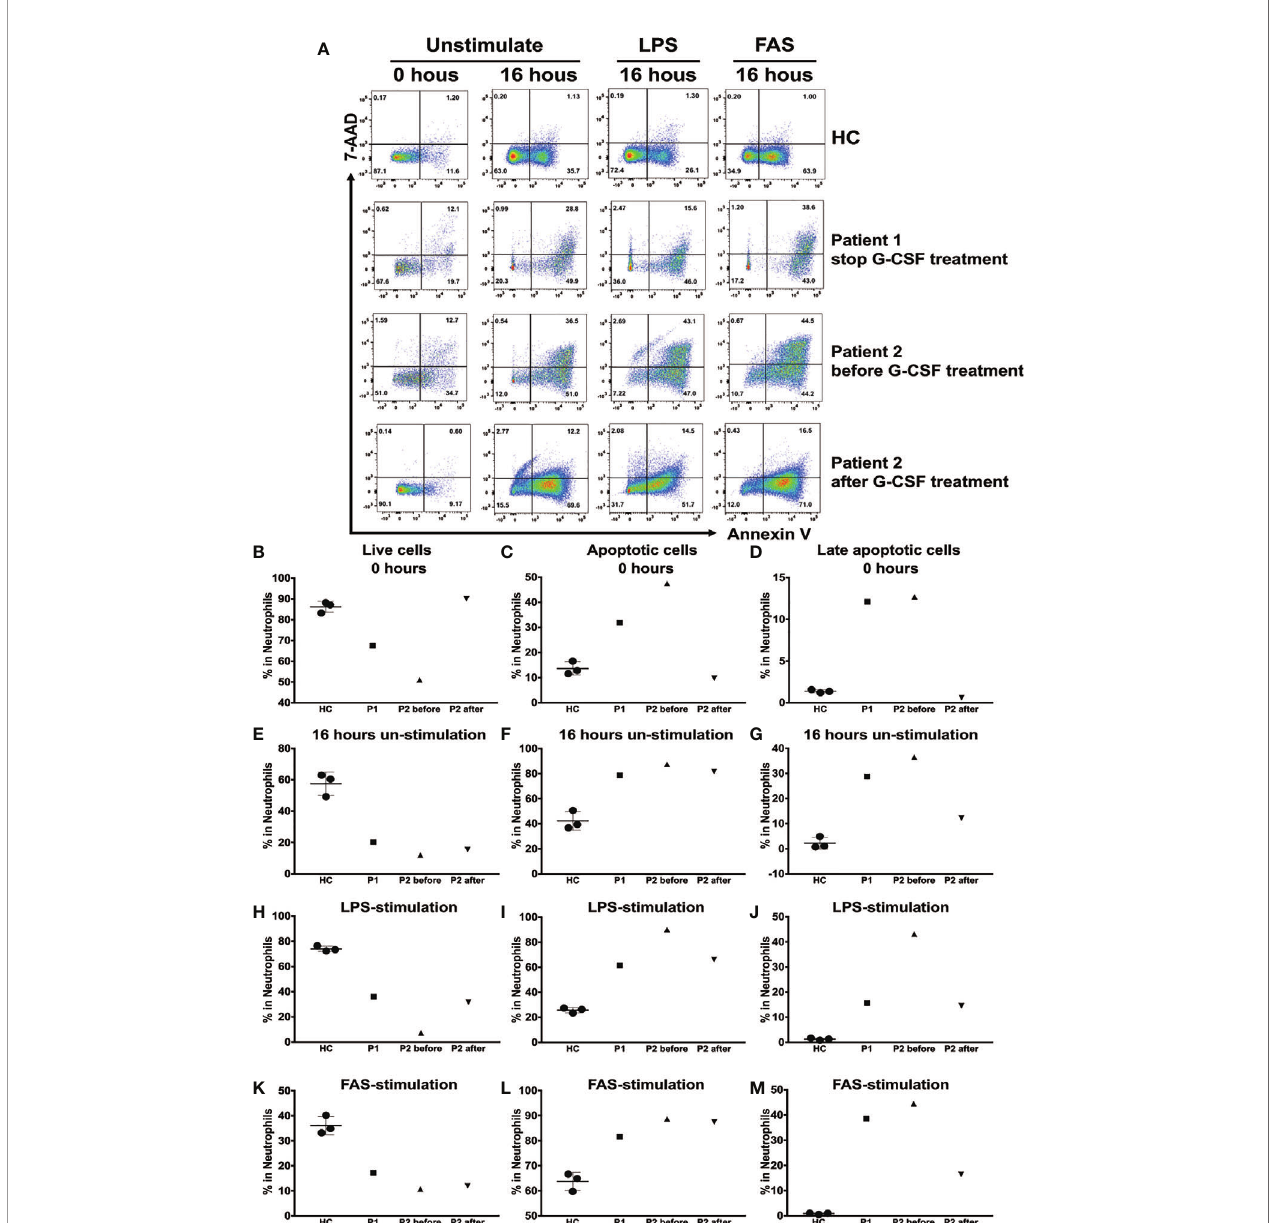
FIGURE 5 | Apoptosis of human neutrophils analyzed using annexin V and propidium iodide staining. (A) Neutrophils from healthy controls (HCs) and patient 1 following cessation of granulocyte colony-stimulating factor (G-CSF) treatment, and patient 2 before and during G-CSF treatment, at baseline and following culture with or without lipopolysaccharide (LPS) or FAS for 16 h. Cells were stained for annexin V and propidium iodide, analyzed using fl ow cytometry. Mean (± SD) percentages of live neutrophils (B) , total apoptotic neutrophils (C) , and late apoptotic neutrophils (D) among total neutrophils at baseline. Mean (± SD) percentages of live neutrophils (E) , total apoptotic neutrophils (F) , and late apoptotic neutrophils (G) among total neutrophils after culture without stimulation for 16 h. Mean (± SD) percentages of live neutrophils (H) , total apoptotic neutrophils (I) , and late apoptotic neutrophils (J) among total neutrophils after culture with LPS for 16 h. Mean (± SD) percentages of live neutrophils (K) , total apoptotic neutrophils (L) , and late apoptotic neutrophils (M) among total neutrophils after culture with FAS for 16